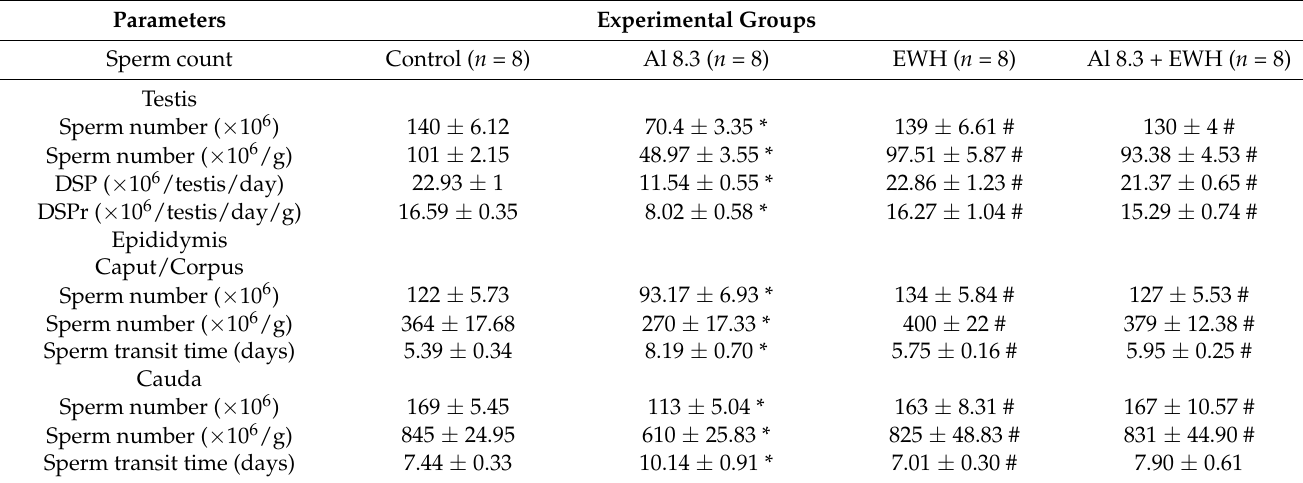
Table 3. Effect of EWH on sperm counts in testis and epididymis of rats exposed to AlCl 3 at 8.3 mg/kg for 60 days.